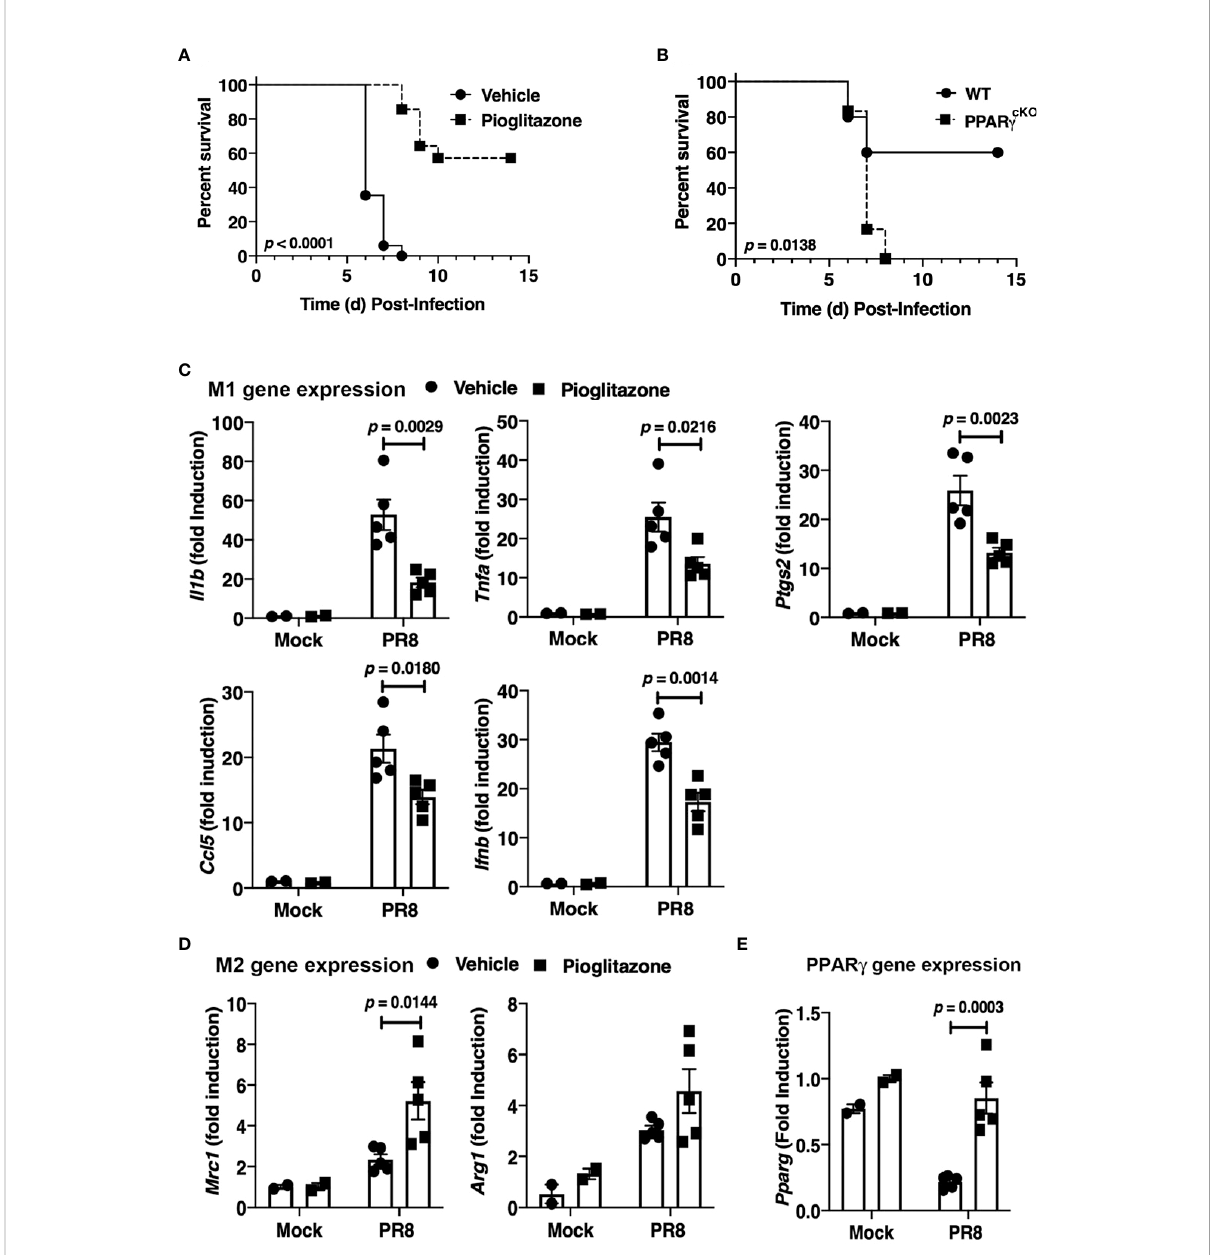
FIGURE 2 Protective role of PPARg in PR8-induced lethality. (A) WT C57BL/6J mice were infected with PR8 on Day 0 and treated on days 2-6 with vehicle or pioglitazone i.p. (6.3 mg/kg). Survival was monitored for 14 days. N = 7-8 mice per treatment group/experiment and 2 separate experiments. (B) WT C57BL/6J and PPAR g cKO mice were infected with an LD 40 of PR8 (~3000 TCID 50 ; i.n.). Mice were monitored daily for survival for 14 days post-infection. N = 5-6 mice per strain/experiment and 2 separate experiments. Survival data was analyzed by the Mantel-Cox log rank test. (C) M1 and (D) M2 gene expression in lungs of mice infected with PR8 and mock-treated or treated with pioglitazone as in (A) . Lungs were harvested at day 6 post-infection. (E) PPAR g mRNA was decreased in response to PR8 infection, but treatment with pioglitazone resulted in normal PPAR g mRNA levels. Gene expression data was analyzed by a 2-way ANOVA with Sidak ’ s multiple comparison